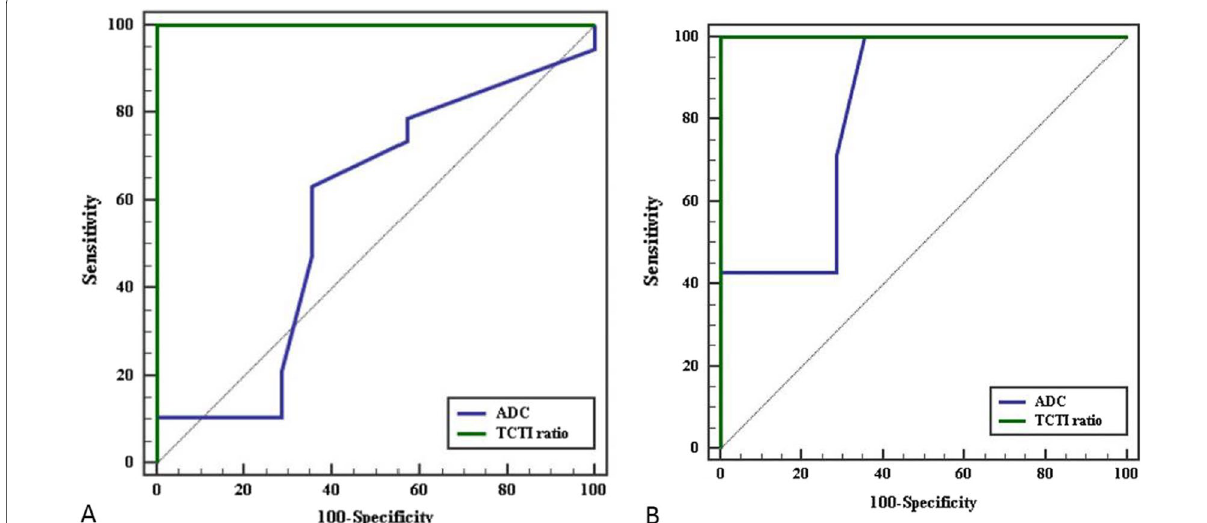
Fig. 5 ROC curve for different parameters (ADC and TCTI) to predict meningioma consistency. A ROC curve for ADC < 0.8 and TCTI > 1.6 for prediction of soft meningioma. B ROC curve for ADC > 0.9 and TCTI